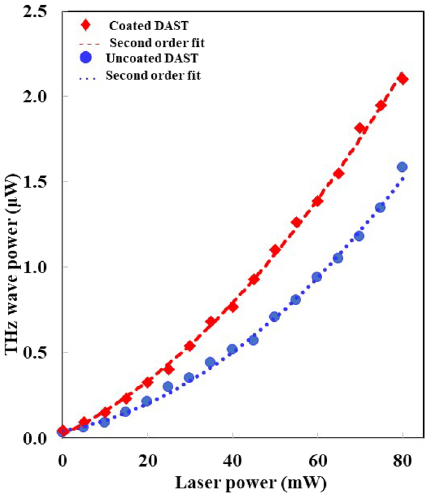
Figure 6. Average power of terahertz wave emitted by antireflection film coated and uncoated DAST crystals.